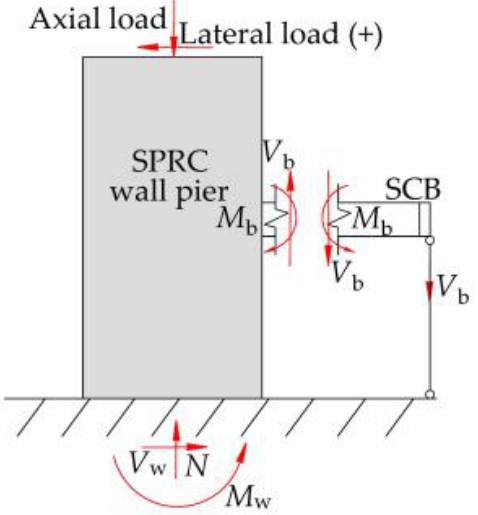
Figure 9. Boundary conditions of test subassembly.